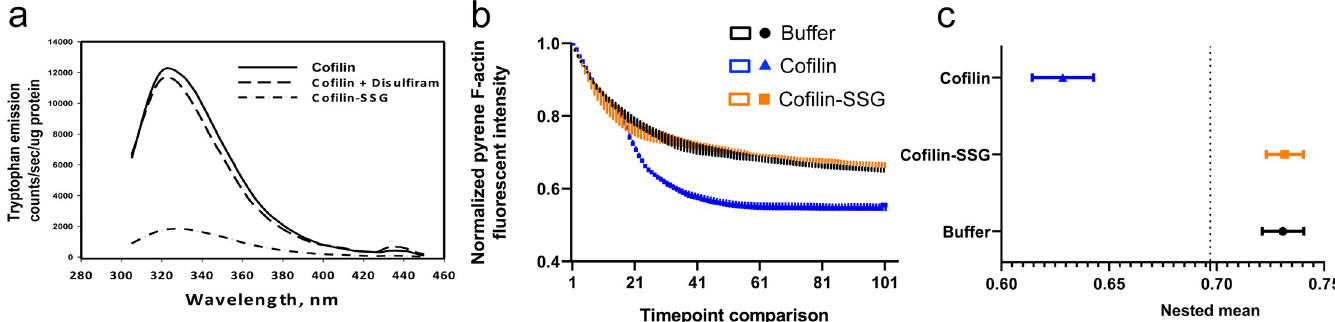
Fig 2. Cofilin-SSG has an altered 3D conformation and is inhibited in its ability to de-polymerize F-actin. (a) Intrinsic fluorescent analysis of cofilin-SSG shows a change in the 3D structure. Recombinant cofilin was S-glutathionylated with disulfiram and GSH (cofilin-SSG) and showed a large decrease in tryptophan fluorescence, indicating a 3D structural change. Non-modified cofilin and cofilin + disulfiram only (no GSH) showed no change in intrinsic fluorescence. (b, c) F-actin depolymerization was inhibited by S-glutathionylated cofilin. Pyrene F-actin was incubated with either cofilin or cofilin-SSG at pH 8.0. Cofilin depolymerized F-actin as expected, as indicated by a decrease in pyrene fluorescence, but cofilin-SSG showed no de-polymerization activity. Buffer only (Tris-HCl, pH 8.0) served as a negative control. (F (2, 906) = 111.1, p < 0.001; p = 0.001, buffer vs. cofilin and p = 0.99, buffer vs. cofilin-SSG) by nested one-way ANOVA followed by Sidak’s multiple comparisons test. Data is presented as mean ± s.e.m. in b, c; n =